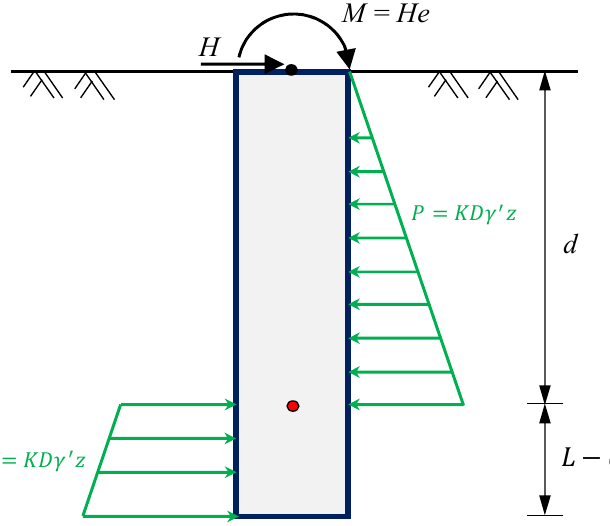
Figure 13. Simplified pile–soil interaction mechanism.